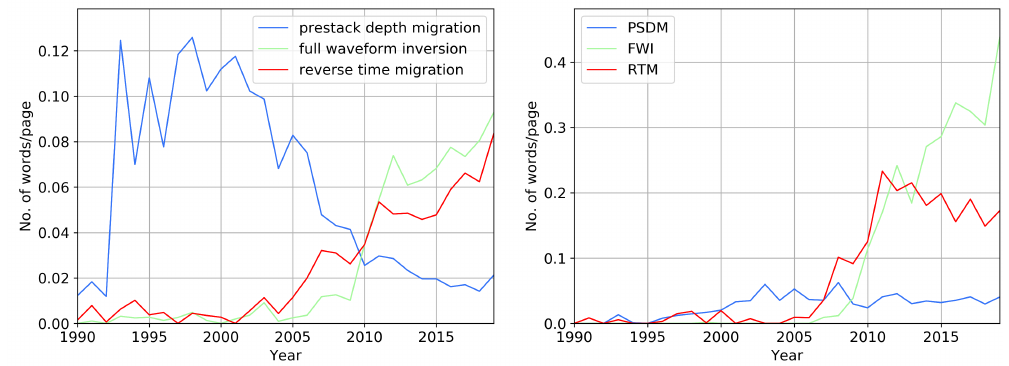
Figure 6. Change in the use of seismic data processing methods: full expression ( left ) and abbreviations ( right ).